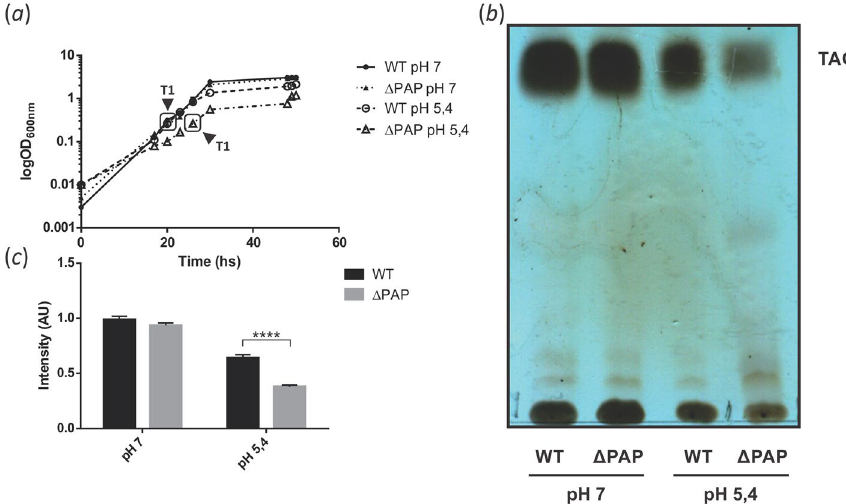
Figure 4. Growth curve and TAG production of M. smegmatis ∆PAP at acidic stress. ( a ) Growth curves of WT and ∆PAP strains in 7H9 medium supplemented with glycerol and tyloxapol (pH 7 and 5.4). Growth was followed by measuring optical density (OD 600nm ). ( b ) Lipids from WT and ΔPAP cells were extracted at the same physiological state at early exponential phase (T1, OD 600nm ~ 0.25) and then analyzed by TLC. ( c ) Quantification of the intensity of the spots present in the TLC showed in panel ( b ). The results are the mean values and standard deviation of three independent biological replicates. All results were normalized by OD 600nm and total protein concentration. Solvent system: hexane:diethylether:acetic acid (70:30:1, v/v/v). TAG, triacylglycerol; WT, M. smegmatis mc 2 155; AU, arbitrary units. Statistical significance was calculated using t-test analysis ;